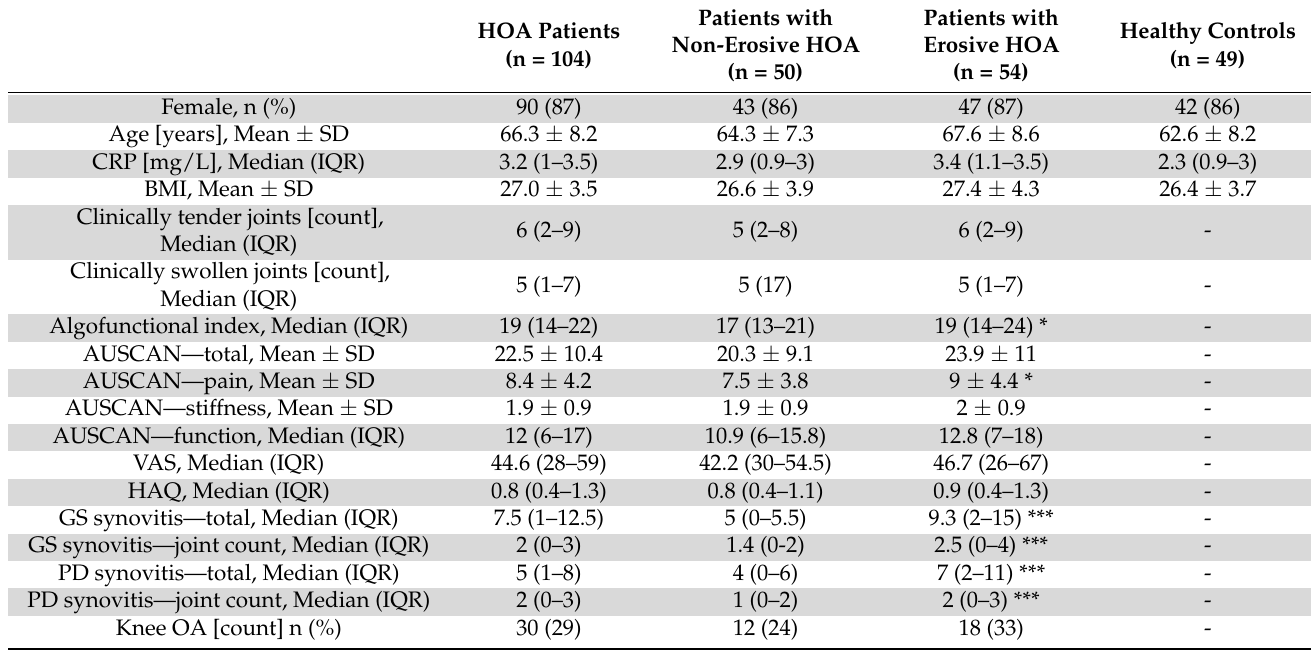
Table 1. Baseline characteristics of patients with hand osteoarthritis and control subjects. The data are presented as mean (the standard deviation; SD) for normal distribution or median (interquartile range; IQR) for deviated distribution. Logistic regression was applied to assess the difference in clinical manifestations between non-erosive and erosive disease. Gender, age, CRP, and BMI served as confounders in the model. p -values were computed using ANOVA. *** p < 0.001; * p < 0.05. Patients with Patients with HOA Patients Non-Erosive HOA Erosive (n = 104) (n = 50)